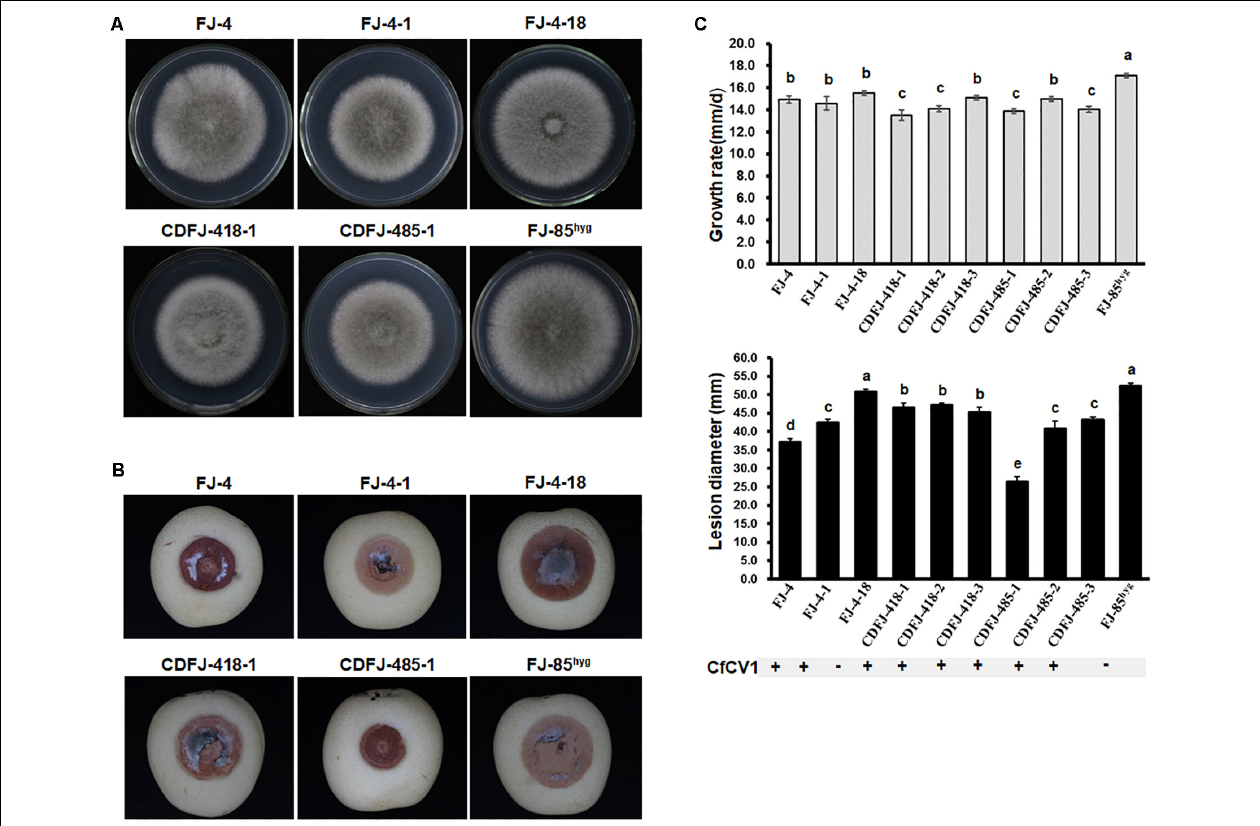
FIGURE 6 | Colony morphology and virulence of strain FJ-4, strain FJ-85 and derived sub-strains on pear fruit. (A) Colony morphology in PDA medium (25 ◦ C, 4 days). (B) Pear fruits wound-inoculated with colonized plugs of tested strains, and photographed at 6 days post inoculation. (C) Statistical analysis of the growth grate and the lesion size. The error bars indicate the SD from three sample means. The letter indicates a significant difference at the P < 0.05 level of confidence according to multiple range test.